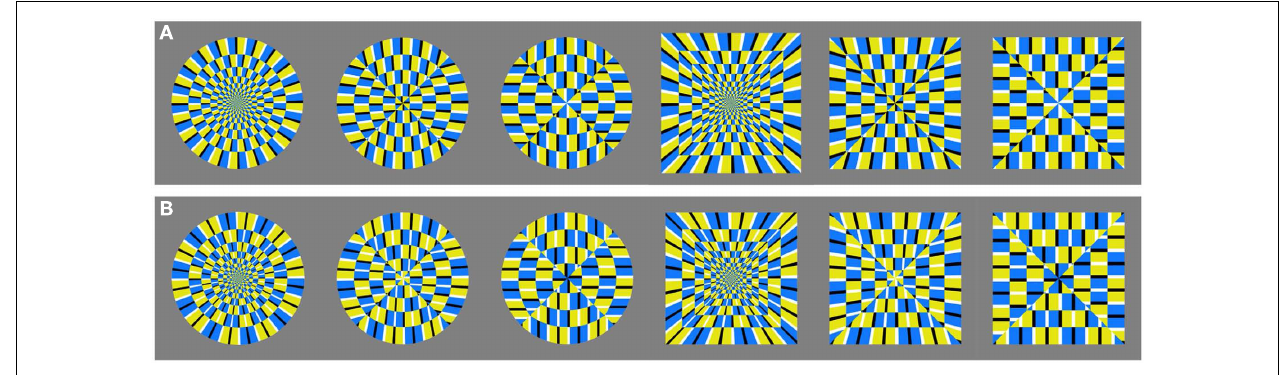
FIGURE 6 |The whole set of stimulus images: (A) the upper panel shows illusory figures, while the lower one (B) shows their non-illusory counterparts: they were matched in features like contour and inner layout, but were not supposed to evoke any illusory